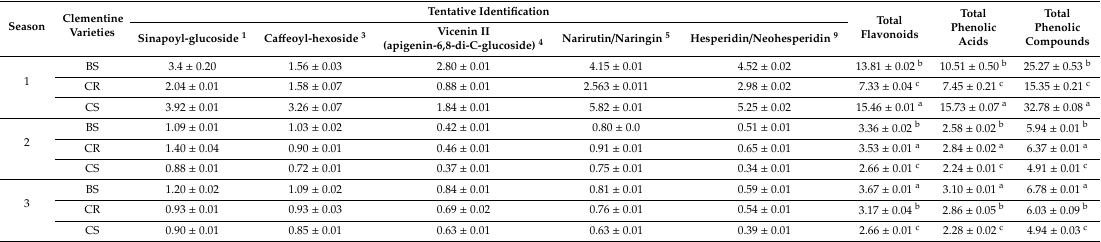
Table 8. Quantification (mg / g of methanolic extract) of the main phenolic compounds in extra early clementine varieties (mean ± SD, n =